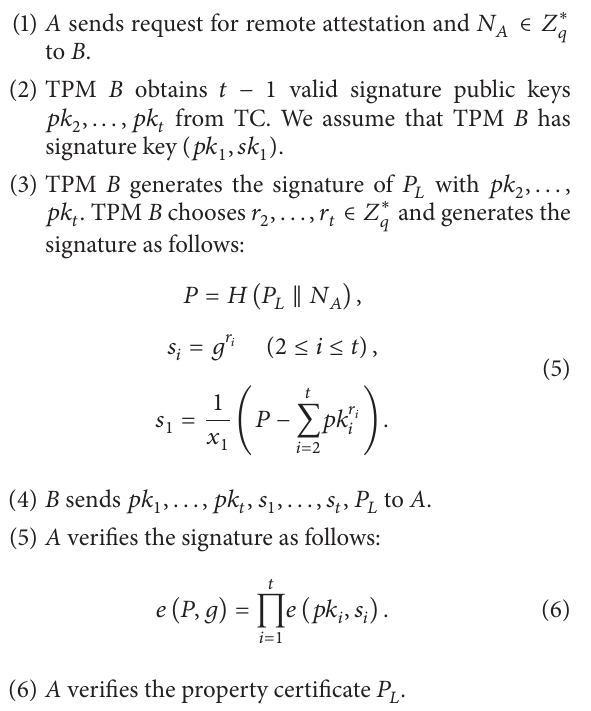
Table 1: The efficiency of the signature. 𝐸 𝐷 𝐻 Amount of calculation of the computing node 1 𝑡 − 1 1 Amount of calculation of the user 0 𝑡